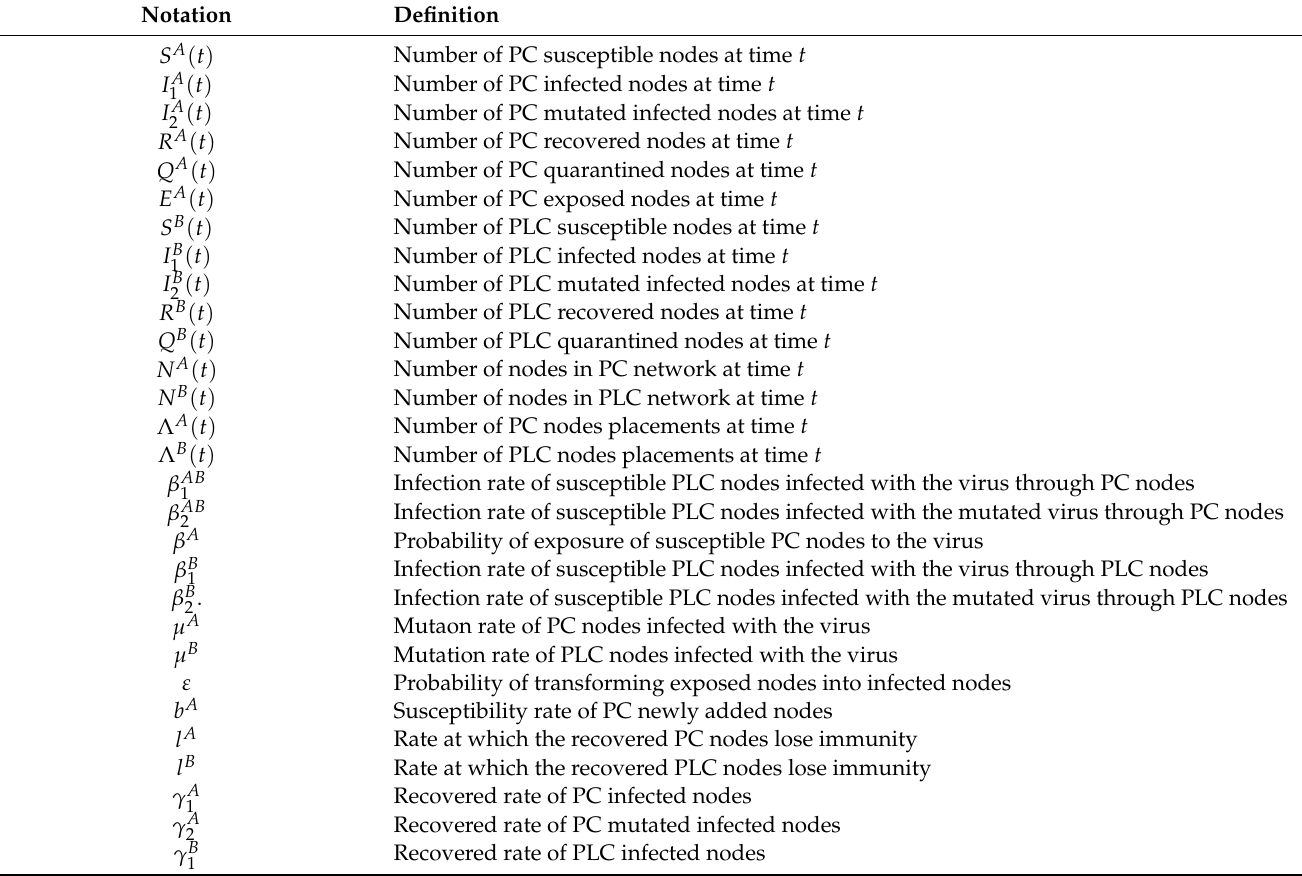
Figure 1. The transformation process of nodes. Table 1. Definition of parameters in the system.